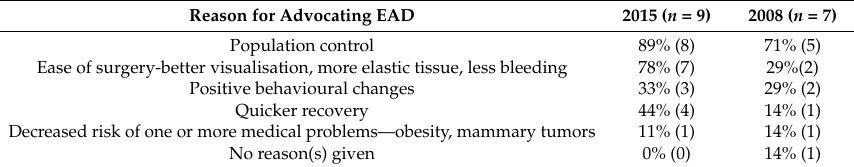
Table 4. Reasons university veterinary teaching staff from Australia and New Zealand in 2008 and 2015 advocated early age desexing; the percentages (and numbers) of respondents nominating each response within each year are shown, expressed as percentages of those answering ‘yes’ or ‘yes and no’ to the question ‘In your teaching of desexing to students of both female and male cats and dogs, are you advocating the use of EAD?’. Each respondent could nominate multiple reasons.